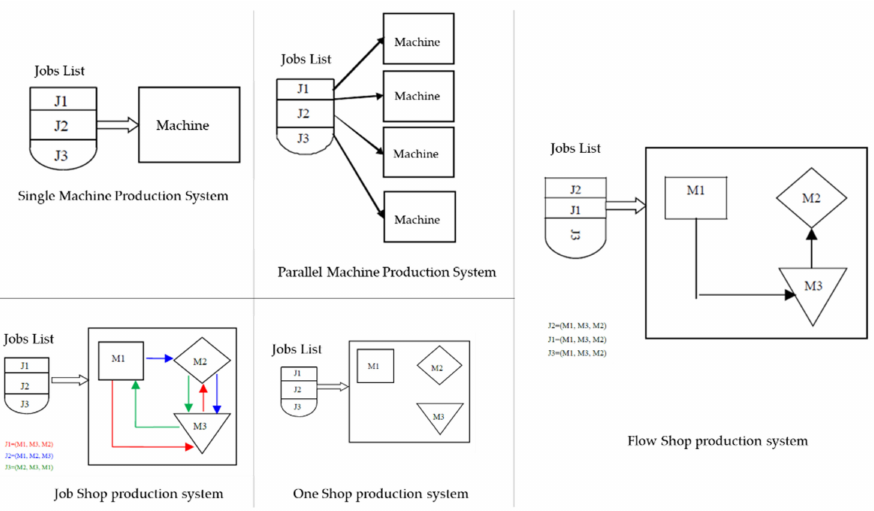
Figure 1. Classification of the main production